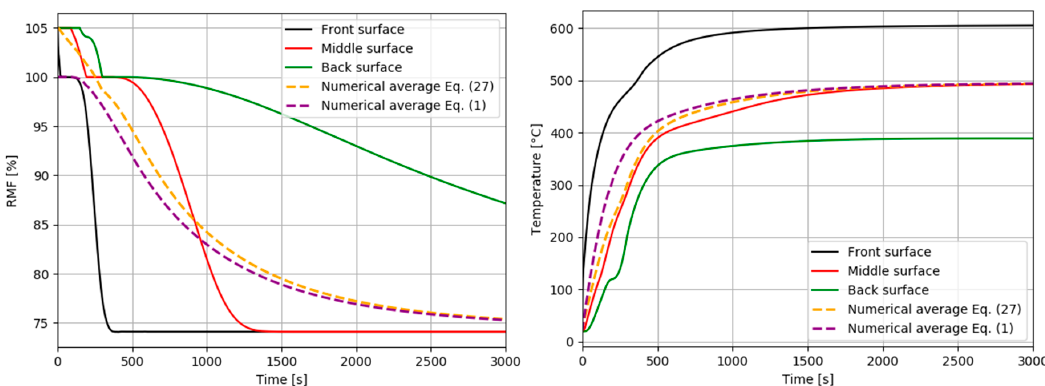
Figure 11. Remaining mass fraction (RMF) profiles and temperature profiles through the material thickness as a function of time. Comparison of numerical simulation prediction as a function of time between thermal and hygro-thermal models for a 9 mm-thick E-glass/vinyl ester composite laminate exposed at a heat flux of 50 kW/m 2.